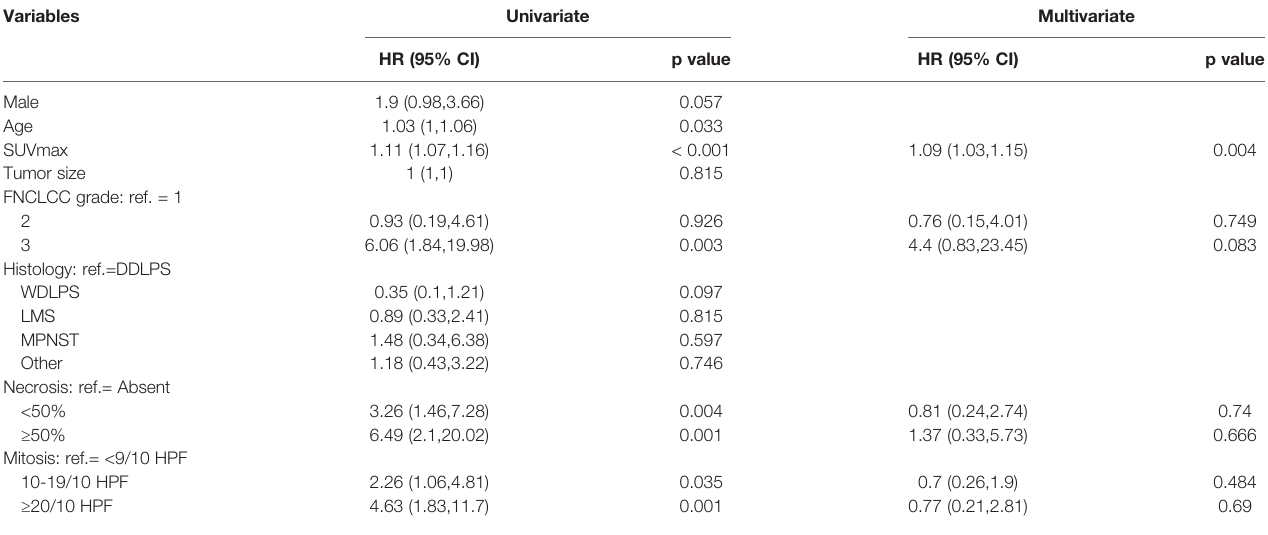
TABLE 2 | Univariate and multivariate analyses of risk factors associated with overall